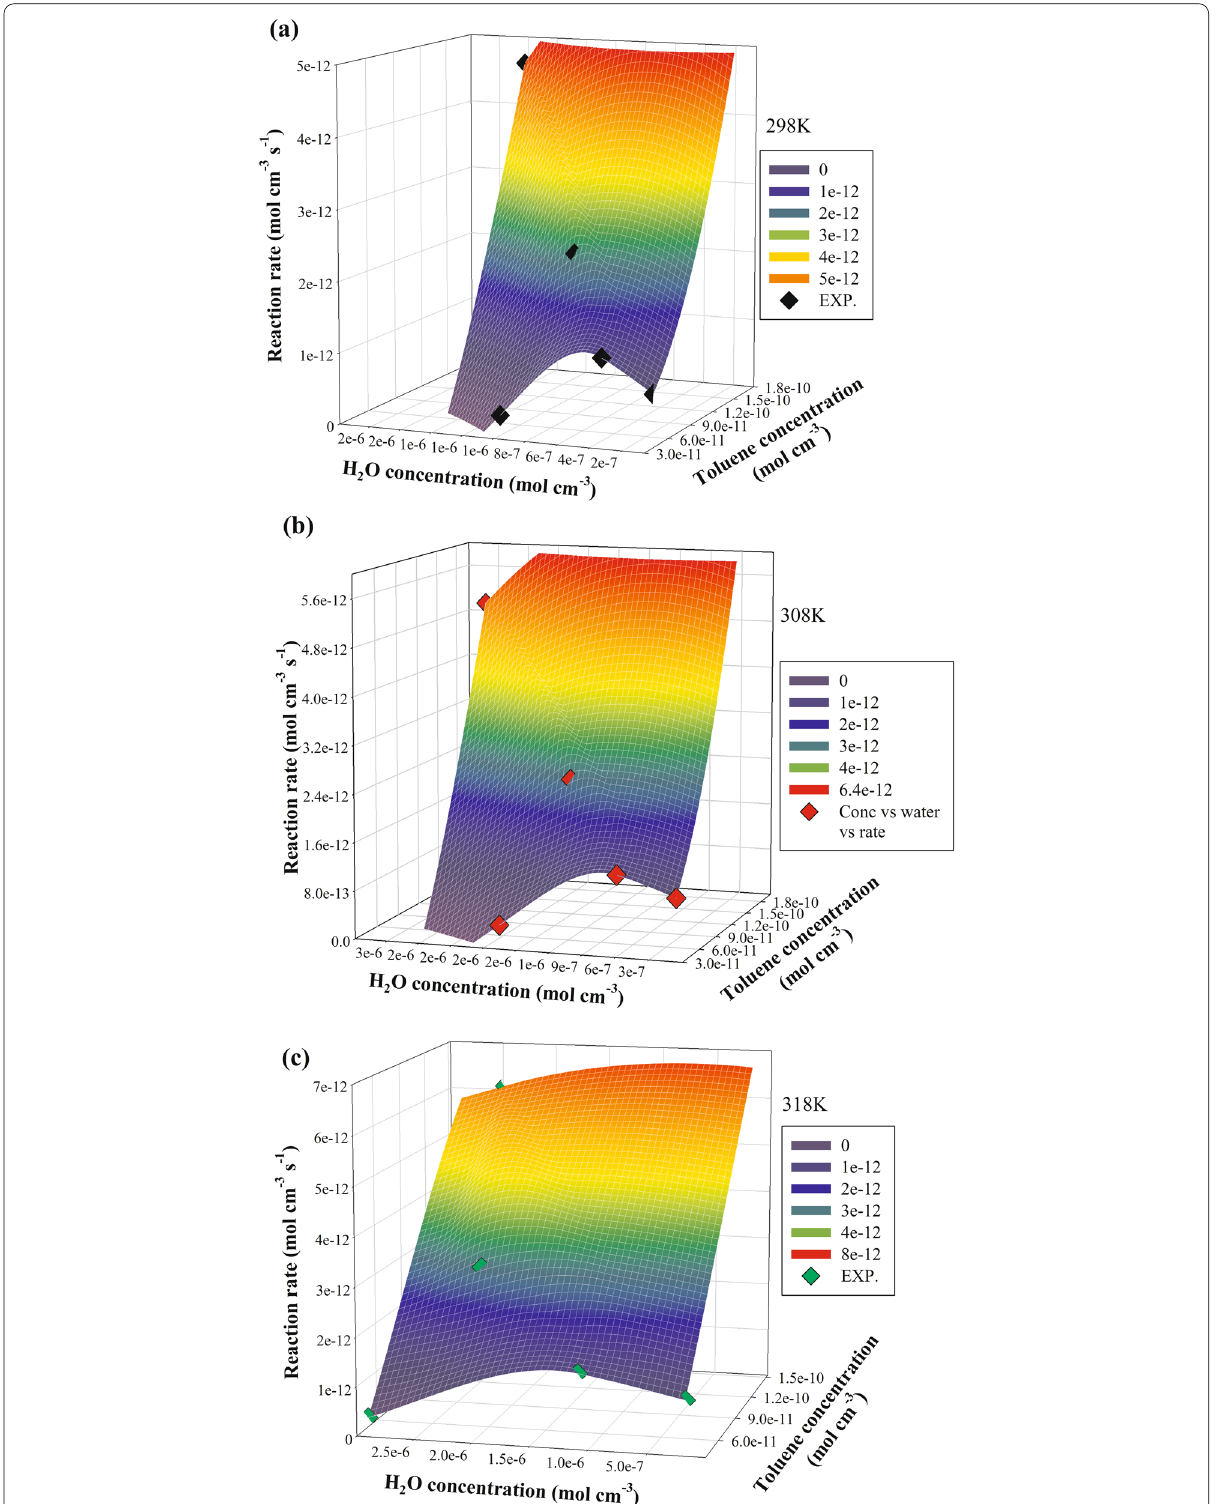
Fig. 8 The reaction rate predicted and experimental values using Langmuir‑Hinshelwood models 4 at ( a ) 298, ( b ) 308, and ( c ) 318